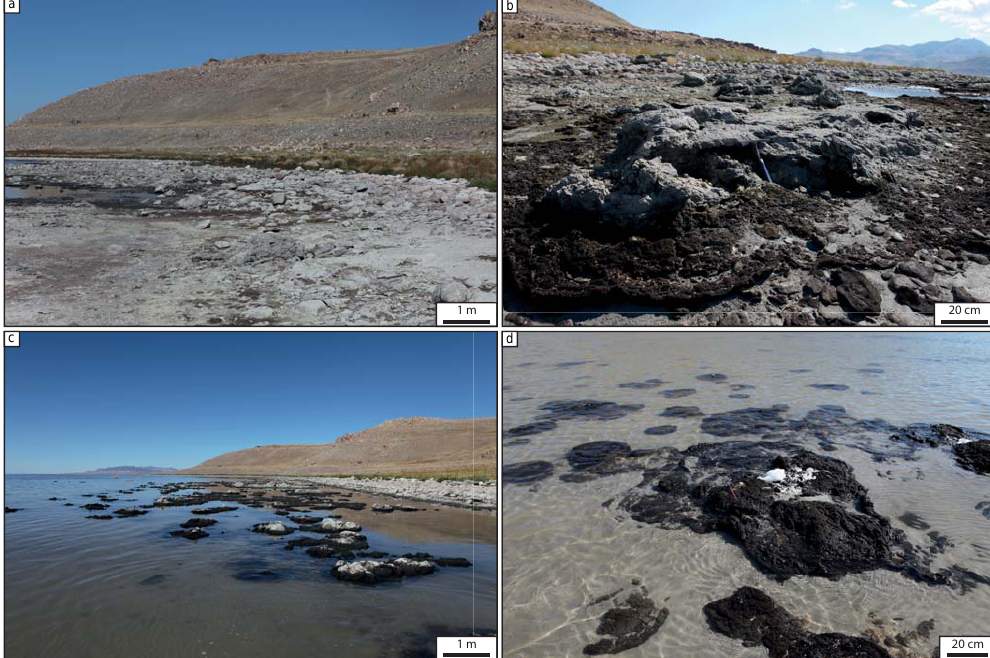
Figure 3. Panoramic view of the depositional environments on the shore. The microbial deposits are fossilized; the non-microbial deposits are dominated by Cambrian quartzite rounded blocks, quaternary microconglomerates and some ooid sands. (b) Details of the microbial deposits located in the area subject to annual water level fluctuations along the shore (2013 shown). The boundary between the living mat and the fossil part of the microbial structure indicates the water level elevation. (c) Panoramic view of the lakeward depositional environment. Most of the microbial deposits (cow-pie structures) consist of a living part (dark brown); the light grey appearance in microbial deposit surface is due to only mineralized structures, suggesting a prolonged period of emersion. (d) Details of the lakeward microbial deposits and the surrounding ooid